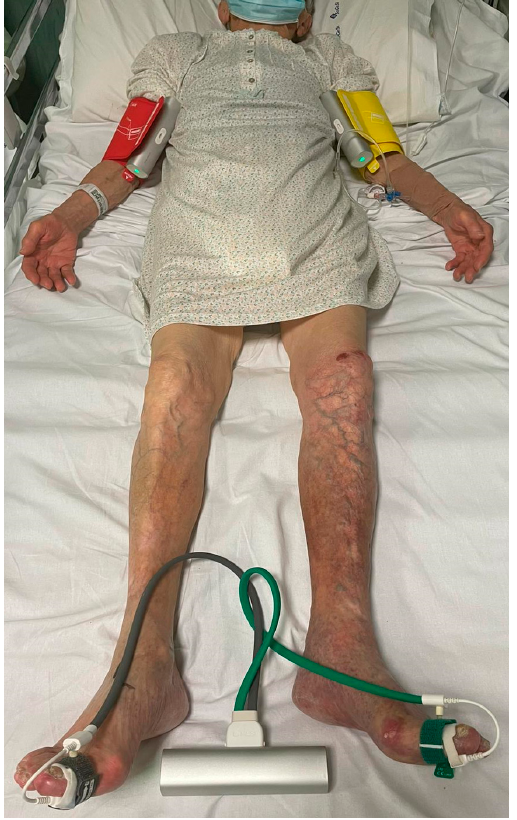
Figure 1. Method used to calculate TBI in patients with CLTI.